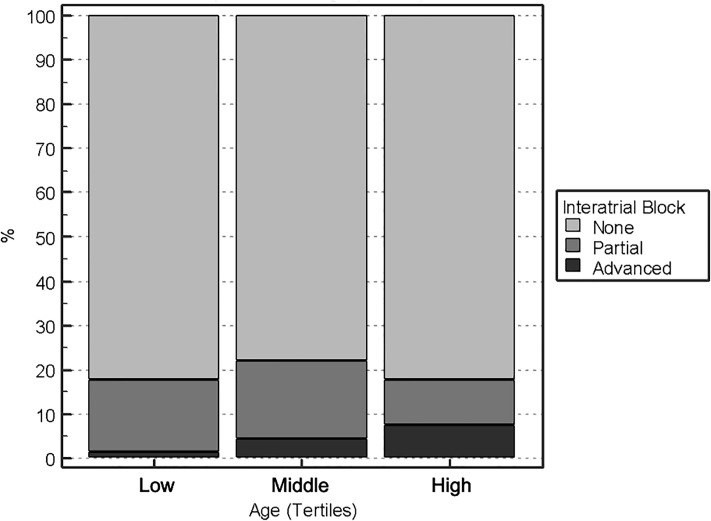
Prevalence of IAB according to age.